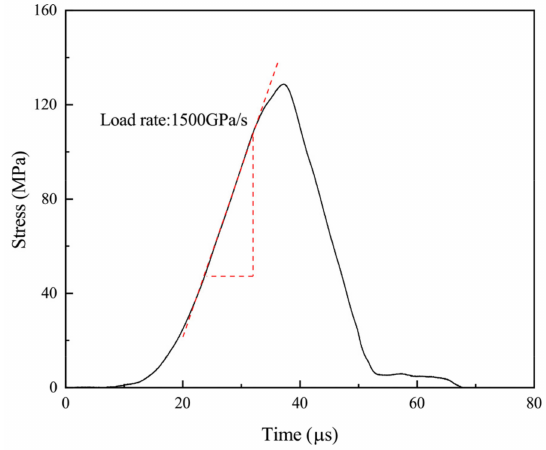
Figure 6. Calculation principle of loading